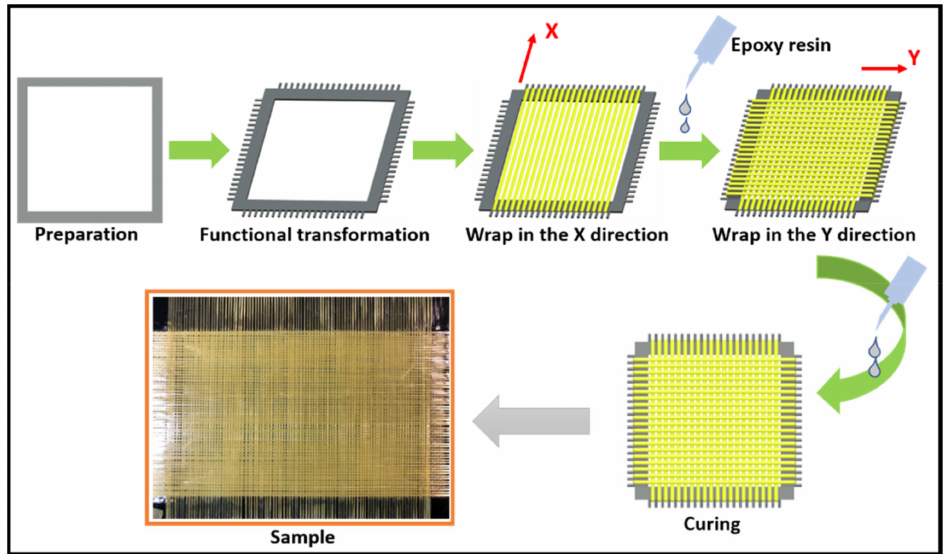
Figure 1. Preparation of the composite